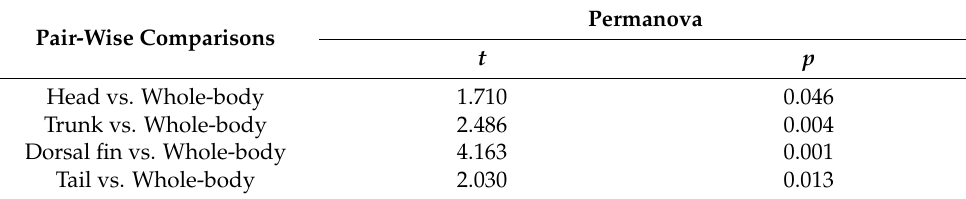
Table 1. Pair-wise comparison of permutational multivariate analysis of variance (PERMANOVA) between the elemental fingerprints of the bony structures of four body parts (head, trunk, dorsal fin, and tail) and the whole body of long-snouted seahorses ( Hippocampus guttulatus ) cultured in Instituto de Investigaciones Marinas (IIM) (Galicia, Spain). ( n = 5). Permanova Pair-Wise Comparisons t p Head vs. Whole-body Trunk vs. Whole-body Dorsal fin vs. Whole-body Tail vs.